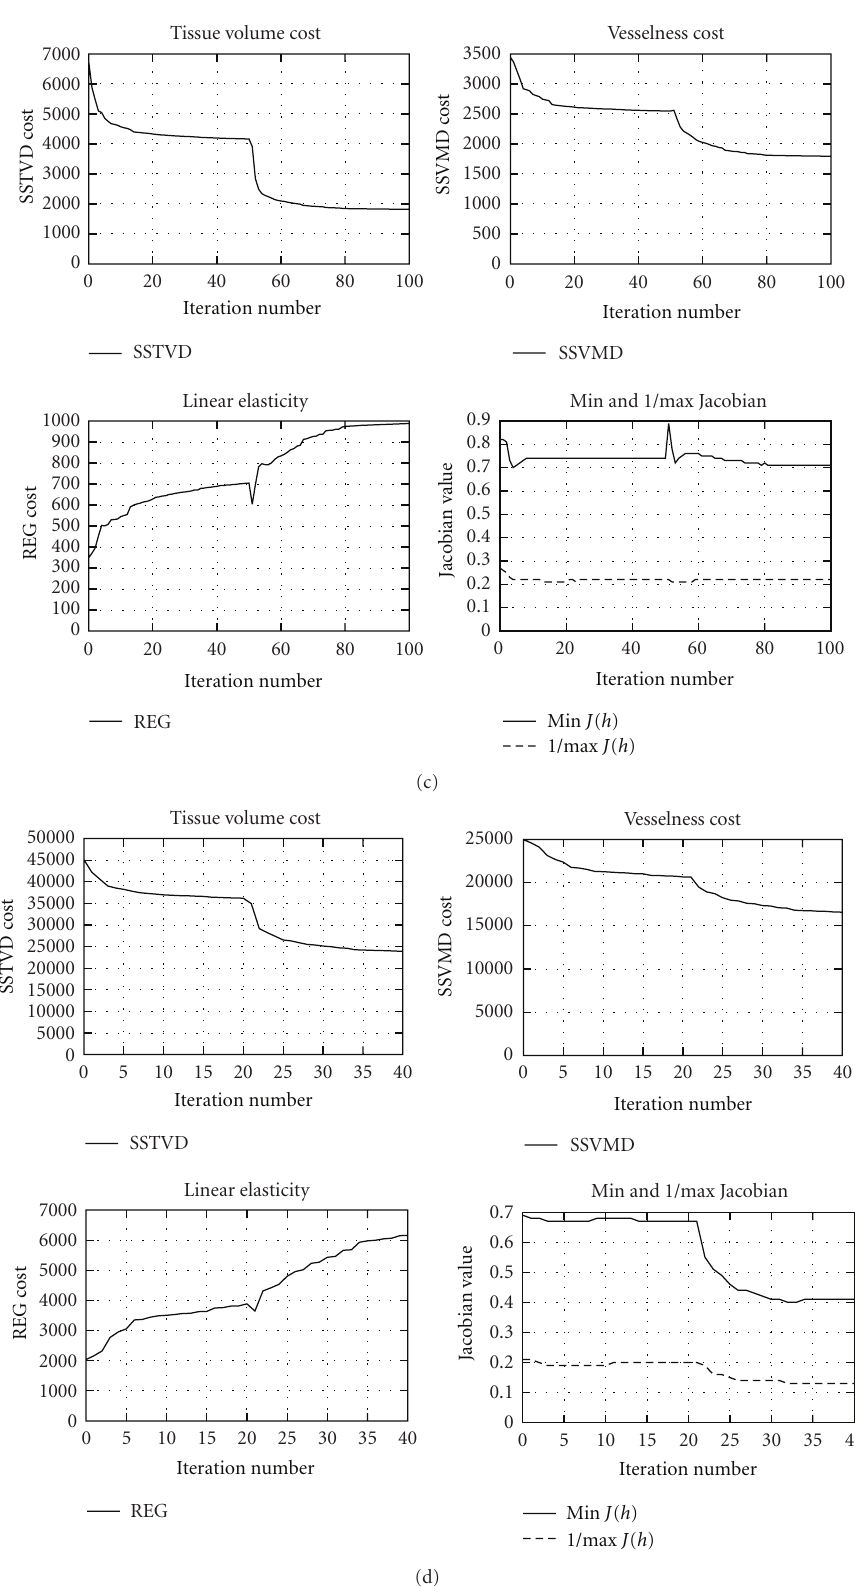
Figure 5: Cost functions versus iteration associated with experiment CT13. Cost function values are recorded at (a) 1/8, (b) 1/4, (c) 1/2, and (d) full image